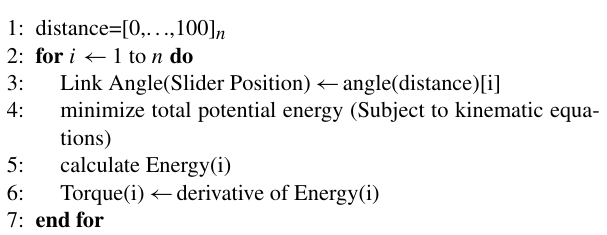
Algorithm 3 Algorithm for obtaining torque and energy within a specified